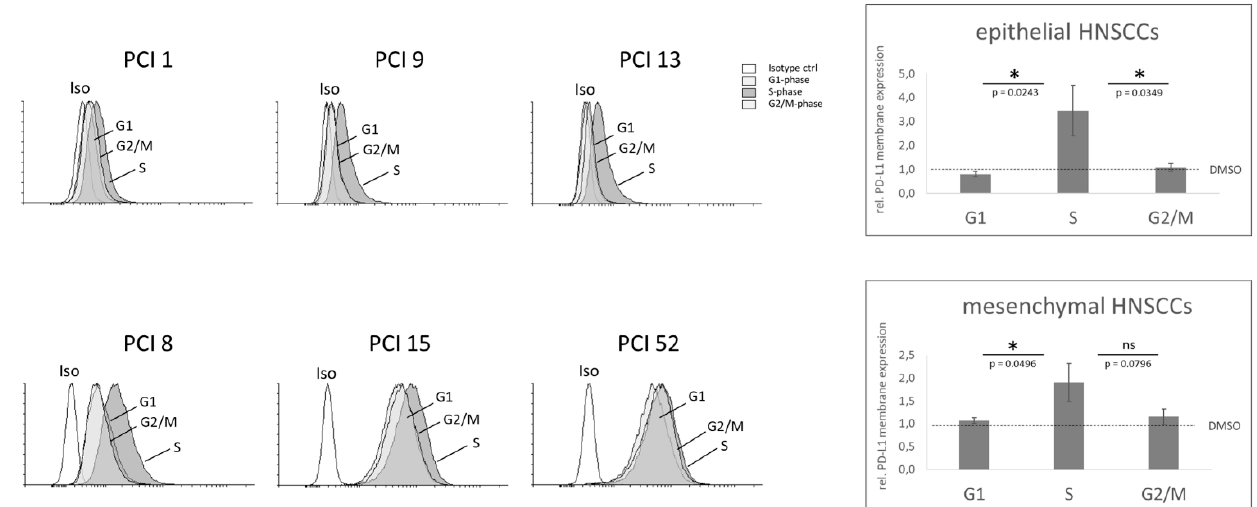
Figure 5. PD-L1 membrane expression during cell cycle progression. Cell cycle progression of the HNSCC cell lines PCI 1, 9, 13, 8, 15, and 52 were blocked during the G1 (grey), S (grey), or G2/M phase (grey). Cell cycle analysis via flow cytometry was performed using flow cytometry. To quantify the DNA content, cells were incubated with DAPI. 5 × 10 4 cells were used per sample. Histograms (left) indicate PD-L1 membrane expression of each single HNSCC cell line. An IgG2 κ isotype antibody (white) was used as the negative control. For signal quantification (right), the three epithelial cell lines (i.e., PCI 1, 9, and 13) and the three mesenchymal cell lines (i.e., PCI 8, 15, and 52) were combined. The DMSO-treated sample of the respective cell line was chosen as the reference (dashed line). The results are expressed as the means ± SD (standard deviation). n = 3, paired t -test (ns = p ≥ 0.05; * = p < 0.05).